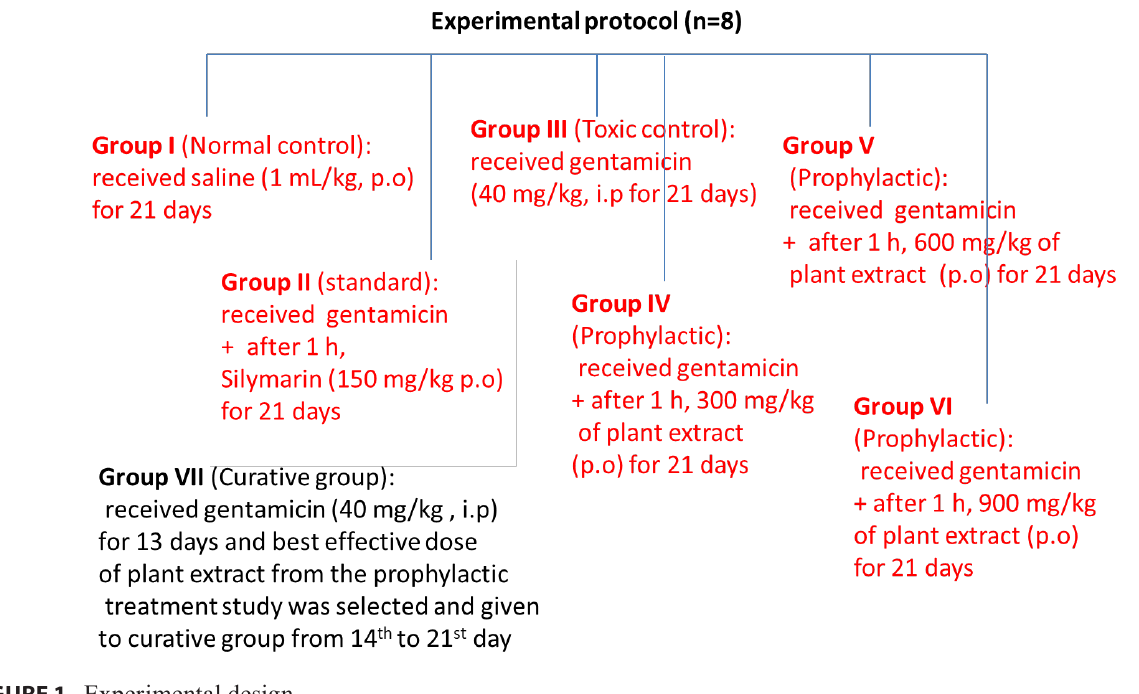
FIGURE 1 - Experimental